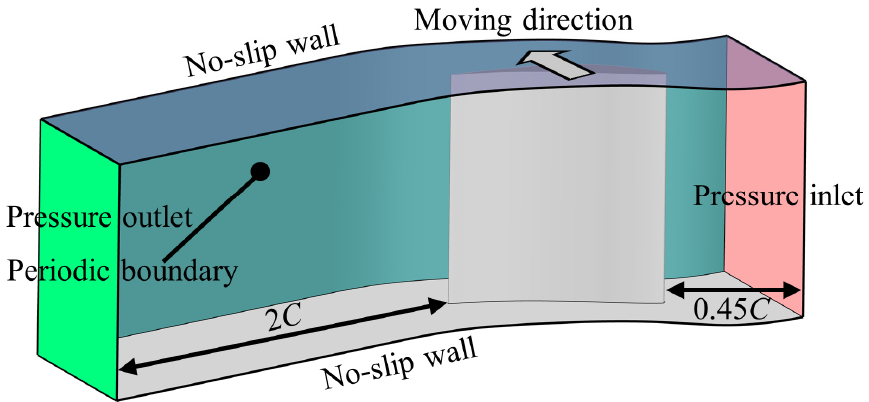
Figure 7. Computational domain.